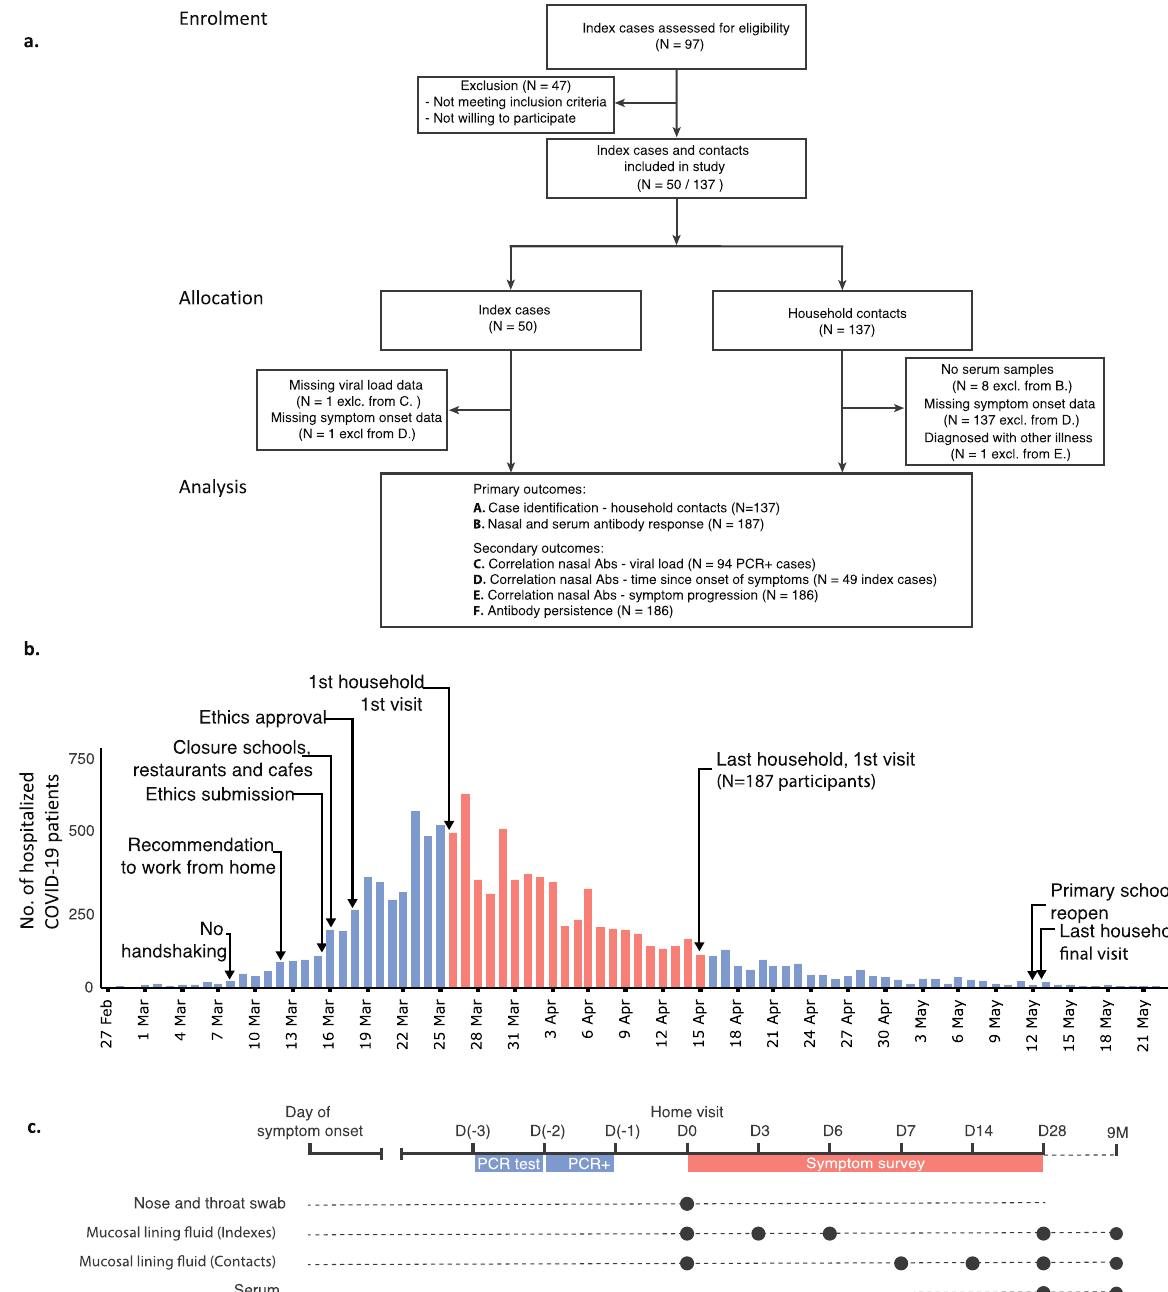
Fig. 1 Flow diagram and study procedures. a Flow diagram describing the recruitment of households, sample sizes, and study outcomes. We initially contacted 97 index cases that were tested positive for SARS-CoV-2. After the exclusion of cases that did not meet the inclusion criteria or did not consent, 50 index cases and their household contacts ( n = 137) were recruited. Mucosal lining fl uid (MLF) antibodies were analysed as a primary outcome in both indexes and household contacts. Secondary analyses (correlation of MLF antibodies with viral load, time of symptom onset and symptom progression and antibody persistence) were performed. b Study timeline, with respect to the number of hospitalisations due to COVID-19 over time and COVID-19 control measures in the Netherlands 46,47 . The fi rst home visit was conducted at the peak of hospitalisations at March 26, and the last visit was one day after the reopening of primary schools, at May 13. c Overview of the study design and measurements. Home visits were initiated after the index was tested positive for SARS-CoV-2 by PCR, to collect naso- and oropharyngeal swabs for viral load determination as well as nasal MLF samples. Subsequent MLF samples were collected and stored by the participants, who also completed a daily symptom survey. At the end of the 28-day follow-up, blood samples were collected for serological analyses. A subset of cases ( n = 108) was visited again 9 months after enrolment. At this timepoint, a MLF and serum sample were taken. Source data are provided as a Source Data fi le.